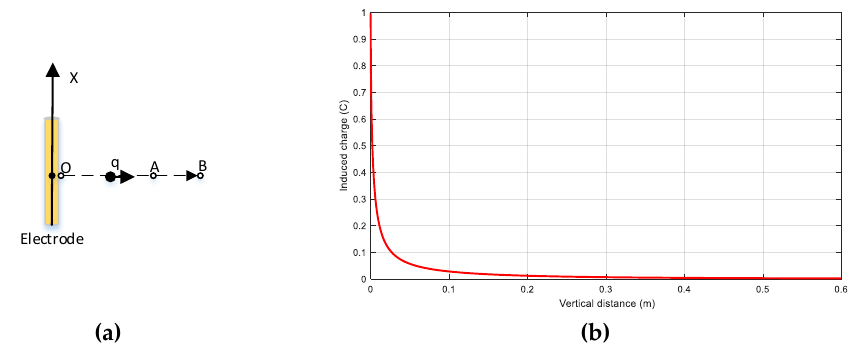
Figure 7. Point charge away from the electrode: ( a ) Charge moving perpendicular to the electrode; and ( b ) induced charge change.